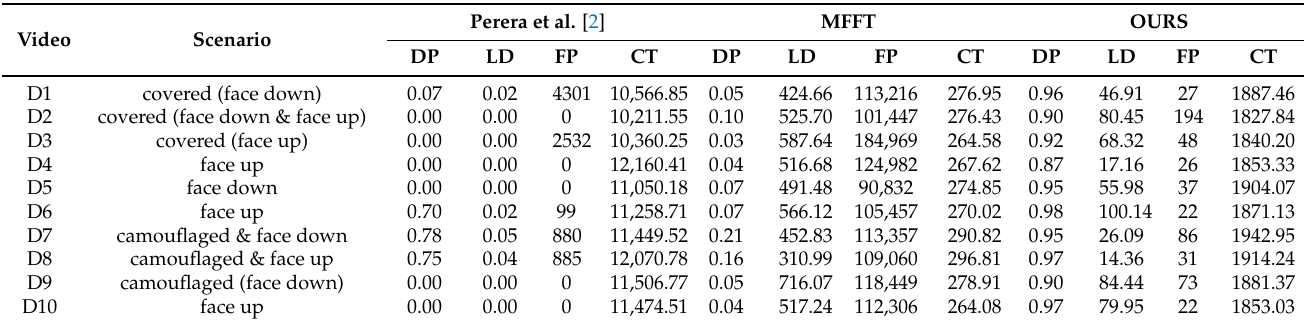
Table 4. Results of detection precision DP , location density LD ( ‰ ) , number of false detected points FP and computational time CT ( s ) of Perera et al.’s work [2], MFFT and ours for ten drone